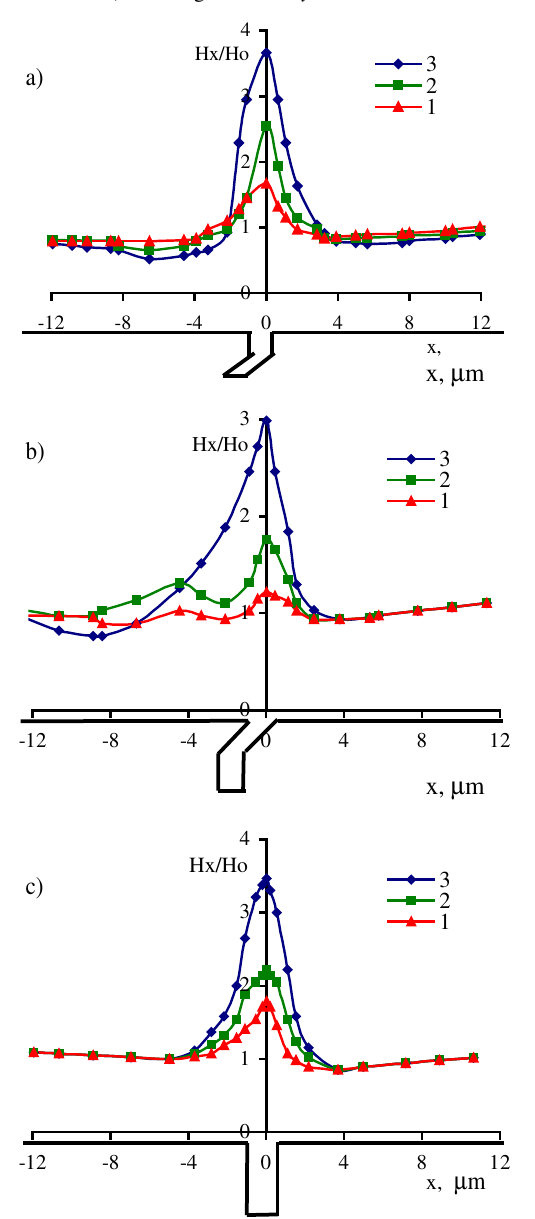
Fig 16. Topography of area with different types of defect ( h = 4 nm; for 1 – 2b = 0.025 nm; 2 – 2b = 0.08 nm; 3 – 2b = 0.2 nm; magnetic intensity on the surface МН : H = 10